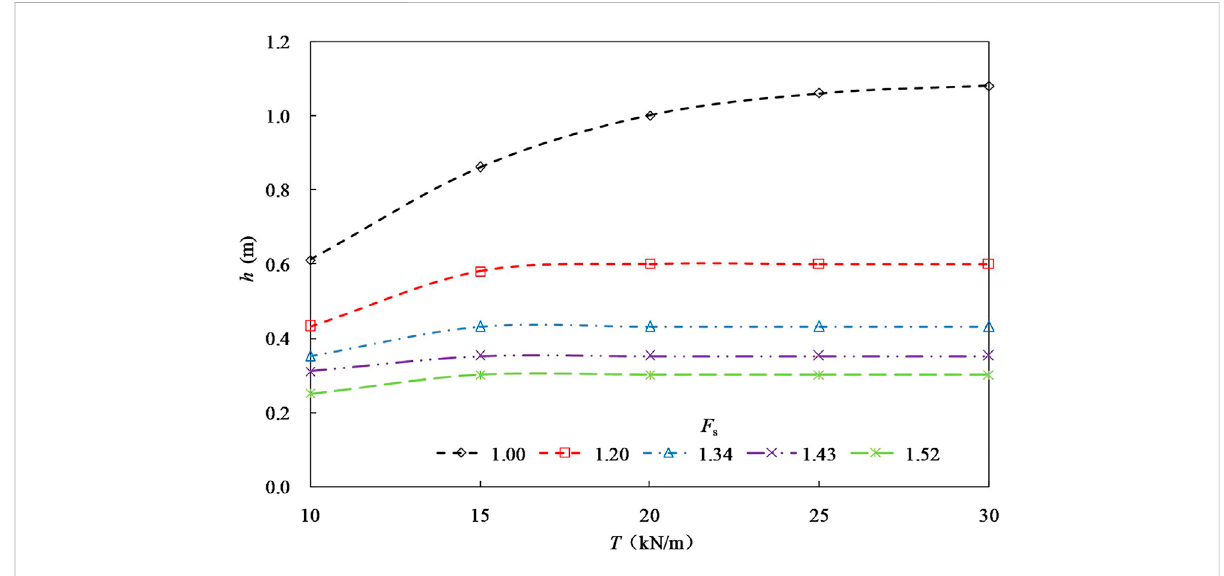
FIGURE 9 Relationship between h and T under different F s